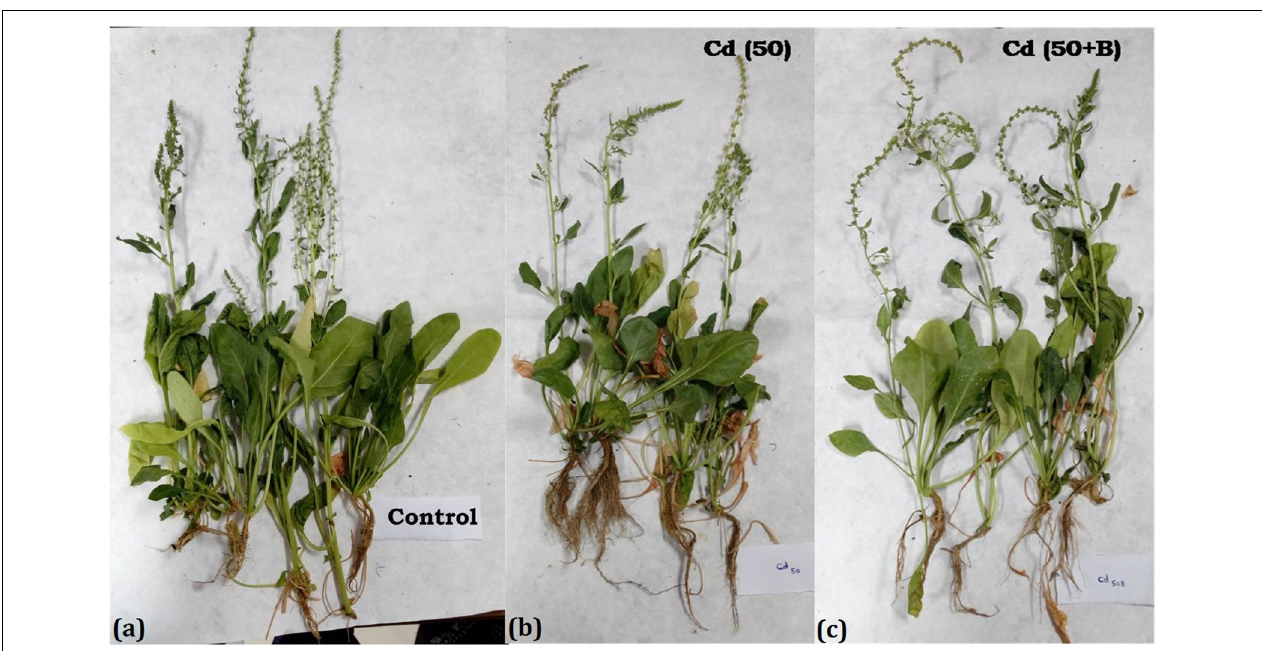
FIGURE 6 | Growth of spinach in the soil treated with Cd and amended with the Ochrobactrum intermedium BB12 at 75 DAI. (a) Control: plants grown in the soil without any treatment; (b) Cd50: plants grown in soil containing 50 mg kg − 1 Cd; and (c) Cd50 + B: plants grown in the soil containing 50 mg kg − 1 Cd and inoculated with O. intermedium BB12.